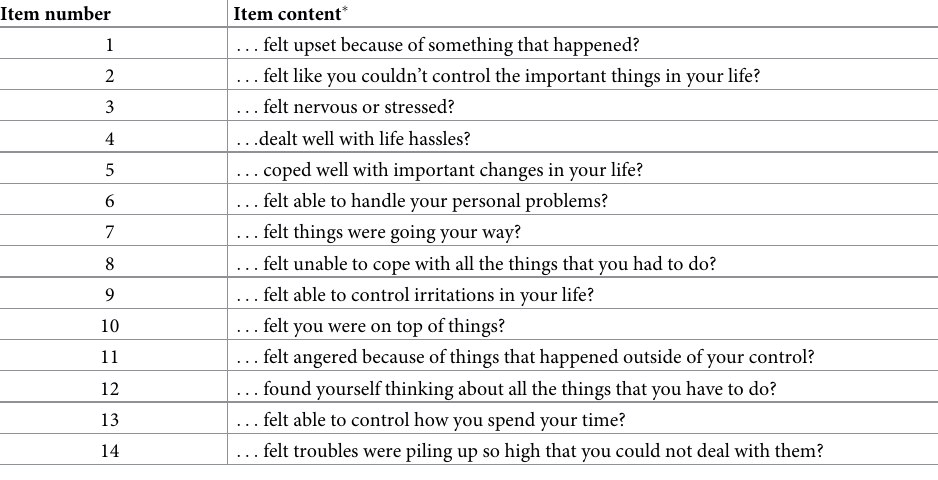
Table 1. New wording of the PSS-14 items after adaptation for an Aboriginal